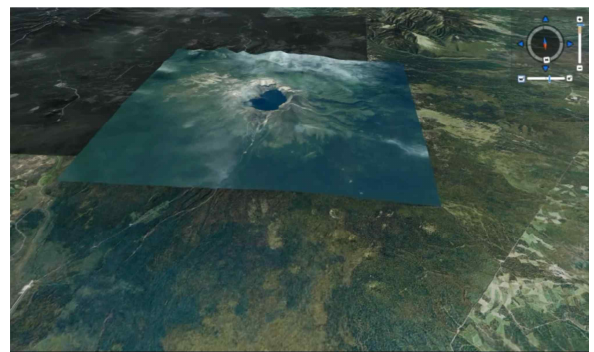
Figure 2. Mt. Baekdu area digital elevation model draped with satellite image-1